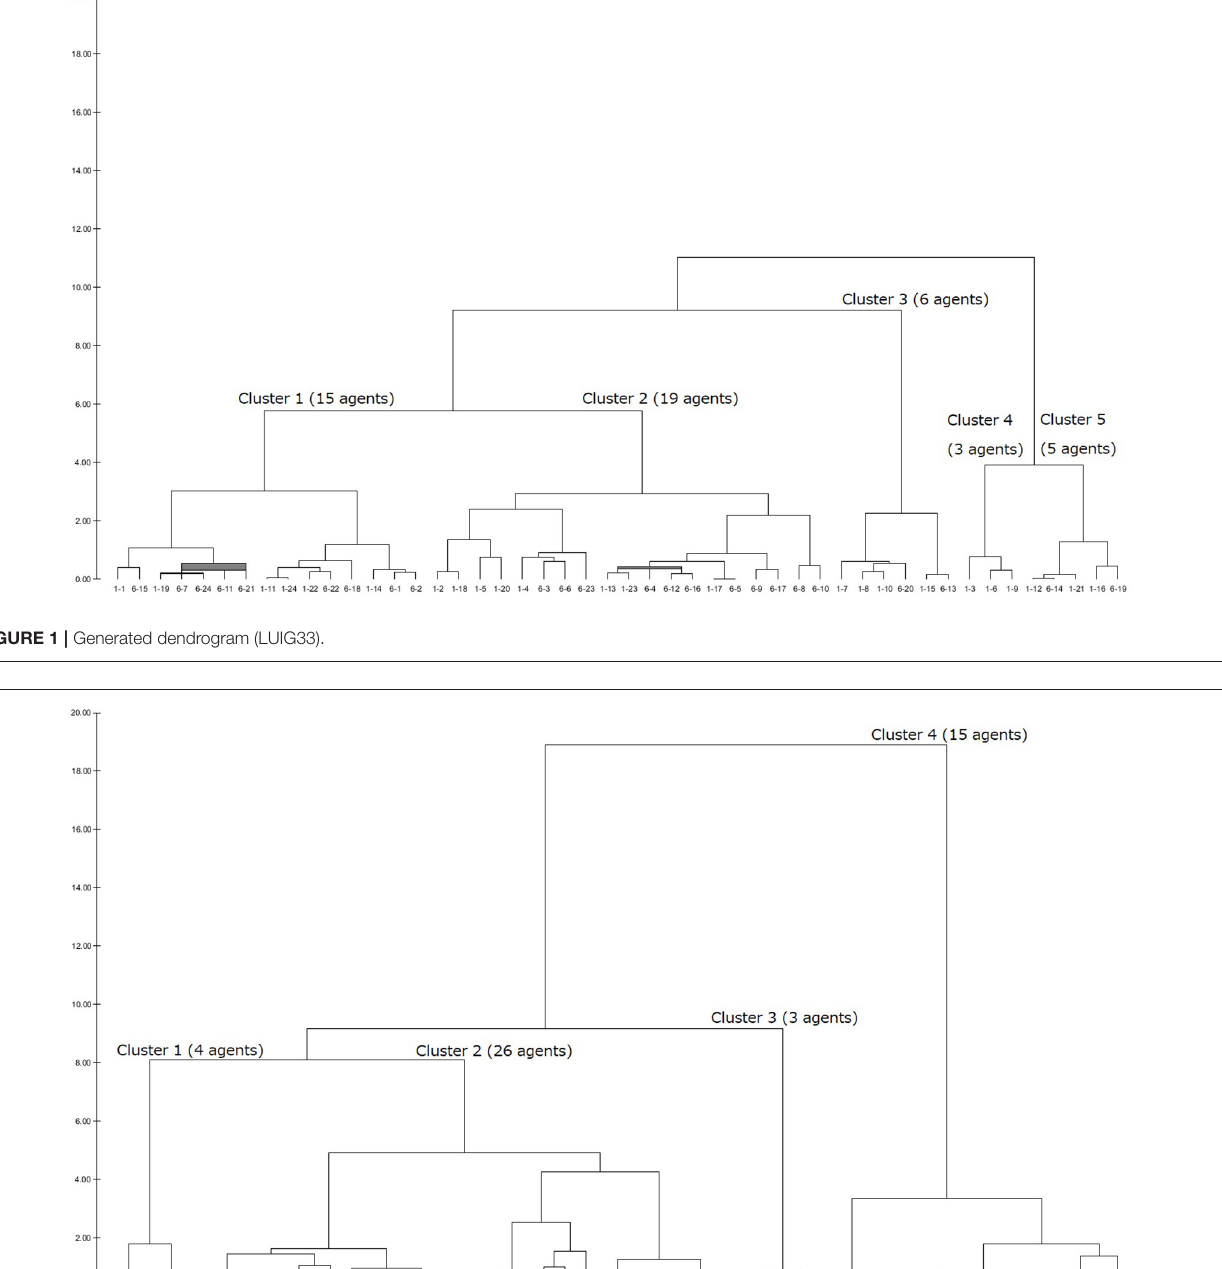
belief to others or view to the game. Then, the learning model with the best log likelihood is employed for the simulation 6 . Note that the subjects who did not change at all in Game 1 belong to